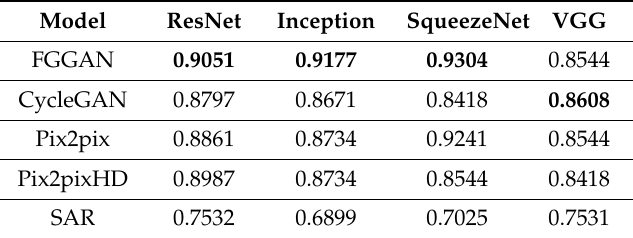
Figure 11. Loss function and accuracy curves of classification experiments using 18-layer ResNet. ( a ) Loss function curve of the training sets. ( b ) Loss function curve of the test sets. ( c ) Accuracy curve of the training sets. ( d ) Accuracy curve of the test sets. Table 6. Top-1 accuracy of the models used in image classification experiments. Bold refers to the best classification result.